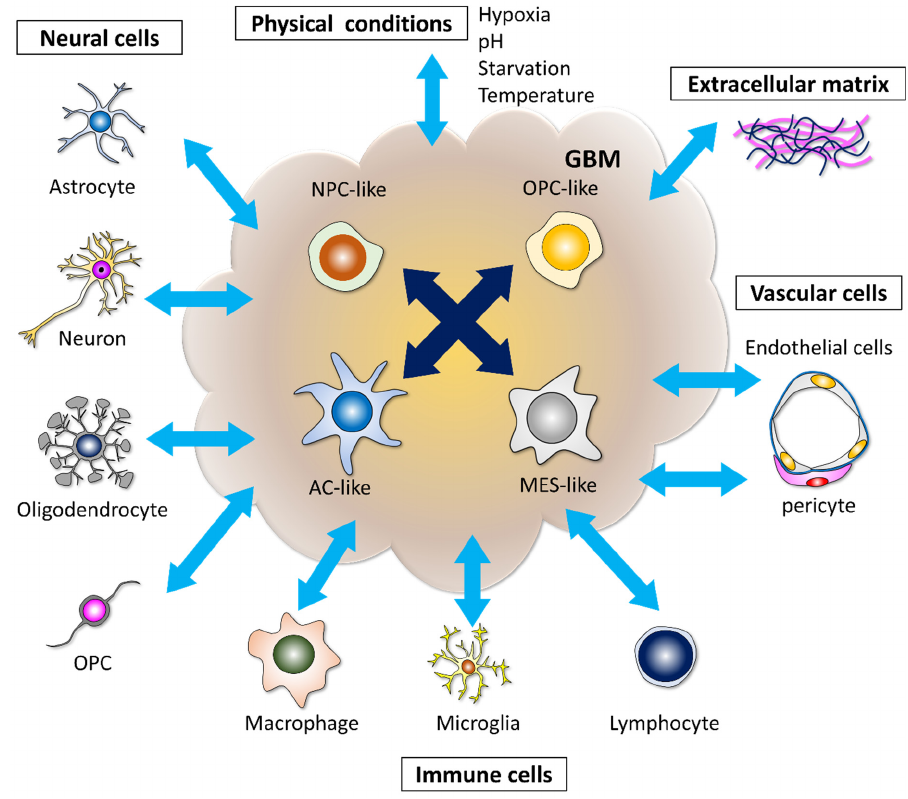
Figure 1. Plasticity and heterogeneity in GBM cells. GBM cells are classified into four subtypes— neural-progenitor-like (NPC-like), oligodendrocyte-progenitor-like (OPC-like), astrocyte-like (AC- like), and mesenchymal-like (MES-like). A single GBM cell can produce all four types of descendants in the xenografted mouse brain under the influence of stimuli from the microenvironment. GBM cells are affected by physical conditions, the extracellular matrix, other GBM cells, and non-GBM cells, including neural cells, immune cells, and vascular cells. The reprogramming of GBM cells is modulated by multidimensional communication in microenvironments. 3. Reprogramming Potential of Glioma Cells 3.1. Indirect Reprogramming and Direct Reprogramming of Non-Cancer Cells Takahashi and Yamanaka demonstrated the possibility of developing induced pluripotent stem cells (iPSCs) by reprogramming fibroblasts transfected with four transcription factors—octamer-binding transcription factor 3/4 ( Oct3/4 ), sex-determining region Y-box 2 ( Sox2 ), Kruppel-like factor 4 ( Klf4 ), and c-Myc —and then iPSCs can differentiate into all three germ layers cells in chimeric mice (Figure 2A) [30,31]. This discovery has had a major effect on the biology and medical fields. Reprogramming can be either “indirect” or “direct” (Figure 2A). Generally, indirect reprogramming means that differentiated somatic cells acquire different cellular phenotypes accompanied by the methylation of DNA and modifications of histones and gene expression profiles [45]. In indirect reprogramming, the cells transit into an iPSC stage and then differentiate into the desired lineage of cells under specific differentiation